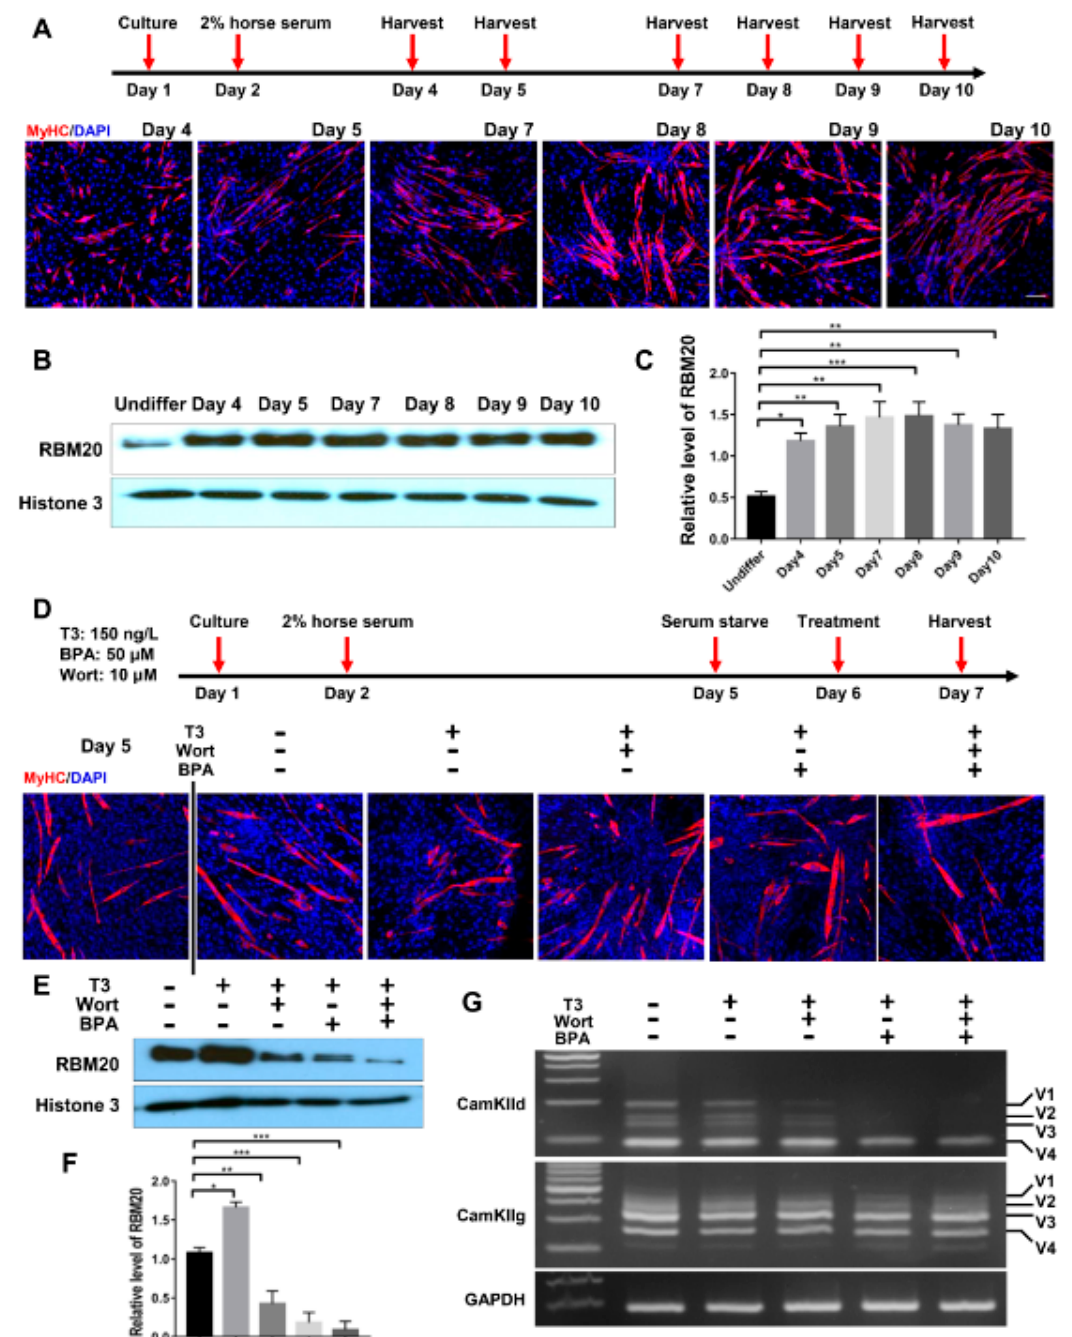
Figure 6. RBM20 expression and gene splicing of CamkIId and CamkIIg in differentiated C2C12 cells via the genomic and non-genomic pathways. ( A ) Cell harvest timeline and Immunofluorescent staining of myosin heavy chain during C2C12 differentiation; ( B , C ) RBM20 expression and quantification during C2C12 differentiation. ( D ) Differentiation and treatment timeline of C2C12 cells with T3, Wort and BPA respectively and immunostaining with myosin heavy chain antibody during C2C12 differentiation; ( E , F ) Western blotting of RBM20 expression and quantification in differentiated C2C12 cells. ( G ) RT-PCR detection of pre-mRNA splicing of CamKIId and CamKIIg genes in differentiated C2C12 cells. CON, control; T3, trriodothyronine; Wort, Wortmannin; BPA, Bisphenol A; Undiffer, undifferentiation; Histone, protein loading control; GAPDH, housekeeping gene; V1-4, splicing variants of CamkIId and CamkIIg. Mean ± SEM ( n = 5), * p < 0.05, ** p < 0.01; *** p < 0.001.